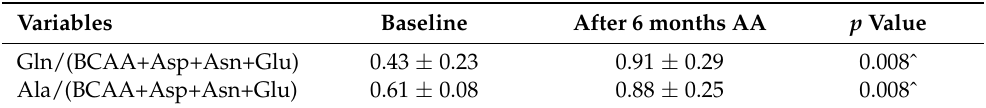
Table 8. Glutamine/(BCAA + aspartic acid + asparagine + glutamate) and Alanine/(BCAA + aspartic acid + asparagine + glutamate) ratio in CKD patients at baseline and after 6 months of AA supplementation. Variables Baseline After 6 months AA